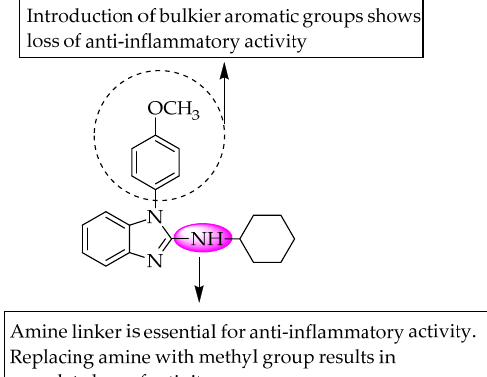
Figure 36 . SARs of 1,2-disubstituted benzimidazoles.